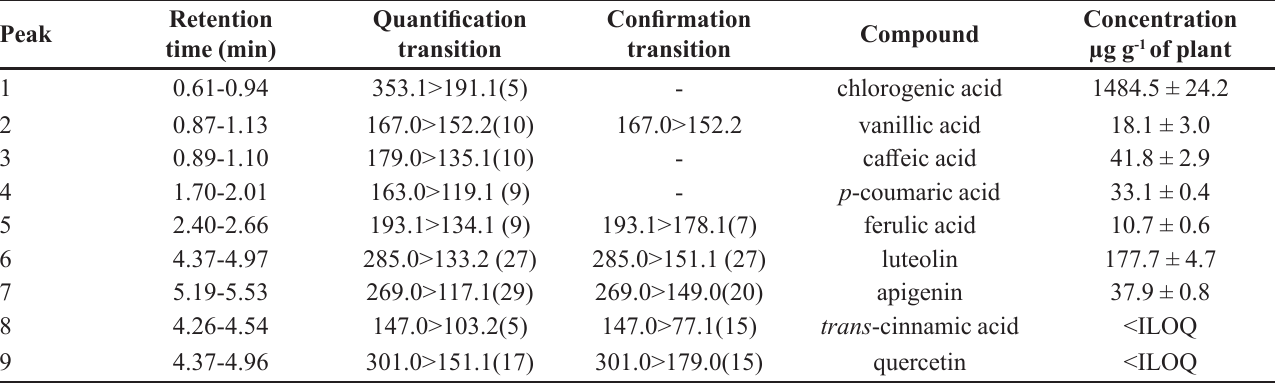
TABLE I - Compounds of V. litoralis crude extract identified and quantified by Ultra High Performance Liquid chromatography coupled with Mass Spectrometry in Tandem (UHPLC-MS/MS)